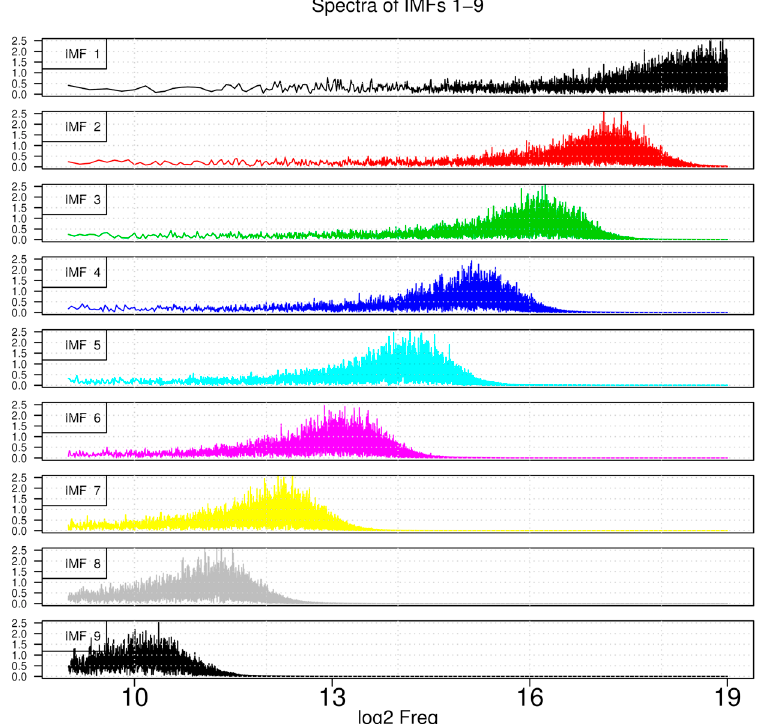
Figure 8. The feature of a collection of band-pass filters within the EMD / EEMD / PEEMD. Panels display the spectra of the first nine intrinsic mode functions (IMFs) that were obtained from the decomposition of Gaussian white noise with one million points. The horizontal represents the logarithm of the frequency (courtesy of [15]).